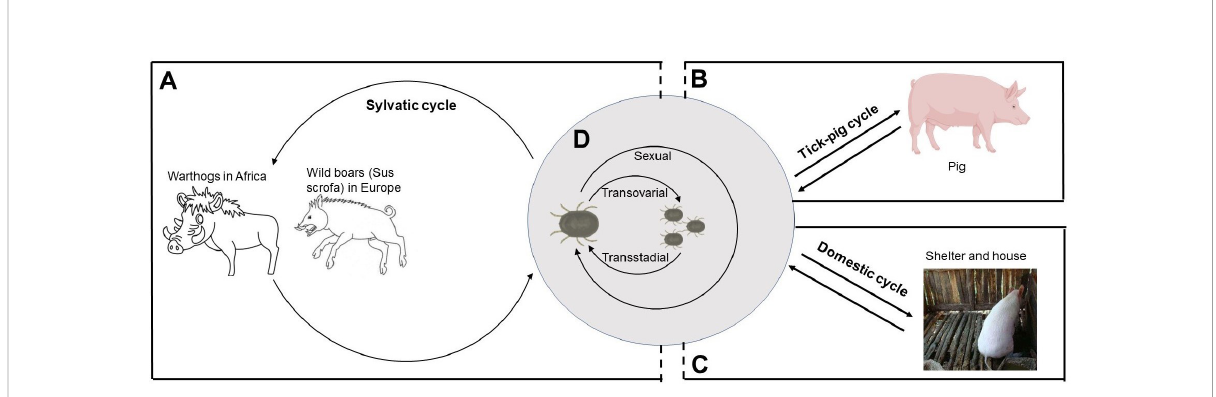
FIGURE 1 The role of Ornithodoros species in ASFV transmission cycles. (A) The sylvatic cycle occurs in Africa and Europe where ASFV is transmitted between Ornithodoros species and warthogs or wild boars. (B) In sub-Saharan Africa and Iberian Peninsula, tick – pig cycle occurs in areas where there is little or no contact between wild and domestic swine. (C) In domestic cycle, ASFV-infected ticks usually hide in shelters and houses during the days and have a blood meal at night. (D) In Ornithodoros species, ASFV is transmitted by transovarial, transstadial, and sexual